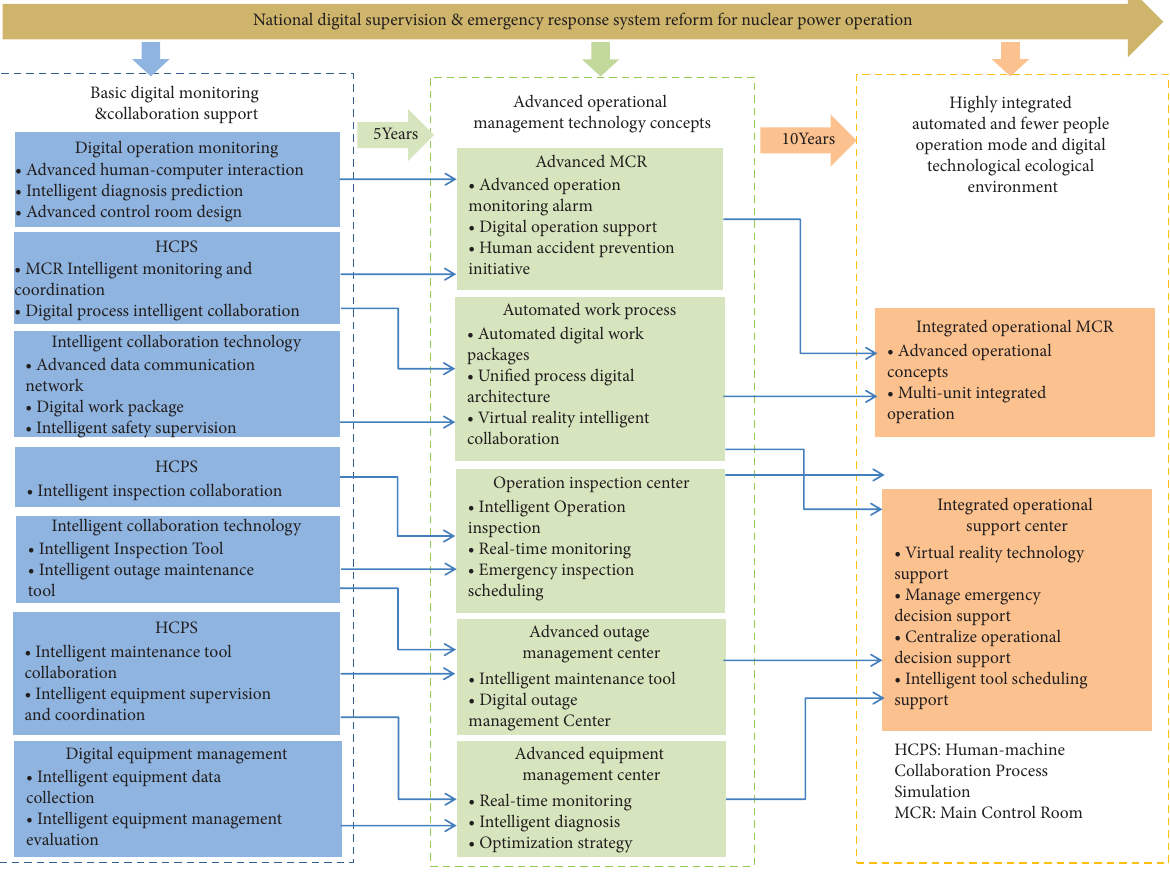
Figure 5: China nuclear power operation sustainable development